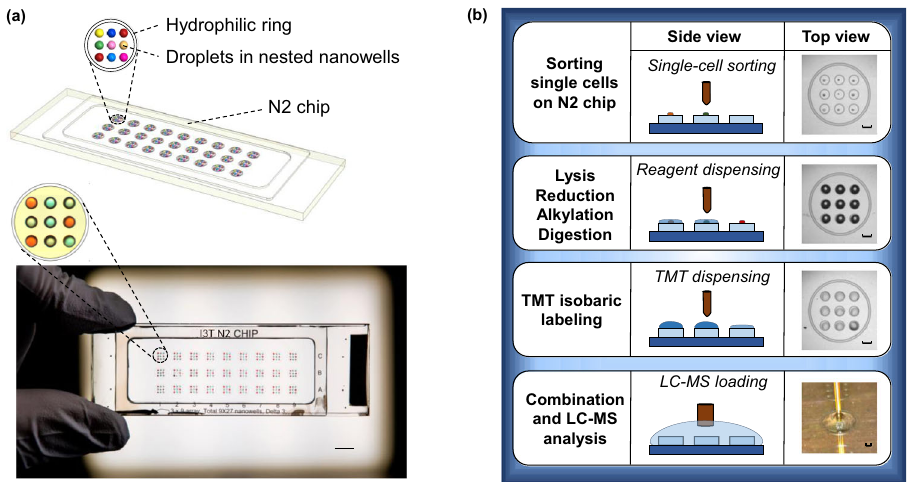
Fig. 1 The design and operation of the nested nanoPOTS (N2) chip. a A 3D illustration (top) and a photo (bottom) of the N2 chip. Nine nanowells are nested together and surrounded by a hydrophilic ring for a TMT set. The length of scale bar is 5 mm. b Single-cell proteomics work fl ow using the N2 chip. The length of scale bars is 0.5 Table 1 Comparison of technical characteristics between N2 and nanowell chips.